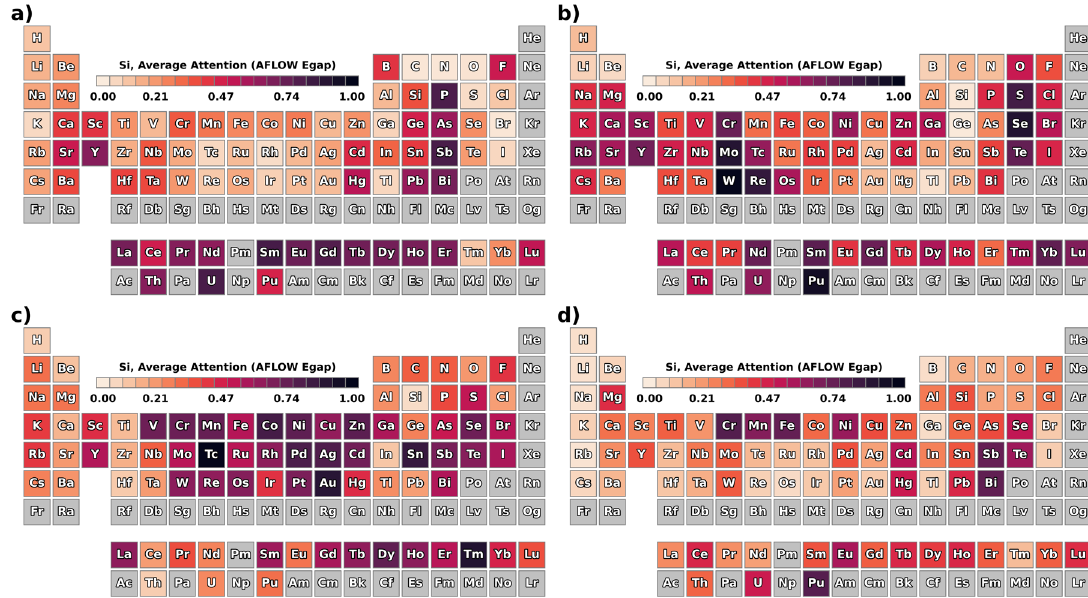
Fig. 3 Visualization of average attention for one dataset. The average attention from each of the four attention heads ( a – d ) from the fi rst layer of a CrabNet model trained on the a fl ow__Egap data is shown for systems containing Si. The heatmap shows the average amount of attention that Si dedicates to the other elements in Si-containing compounds. The darker the coloring, the more strongly Si attends to that element. We can see that each attention head exhibits its own behavior, and attends to different groups of elements. Interestingly, head a attends to common n -type dopants and head c attends to many transition metals, whereas heads b and d have unfamiliar element groupings.